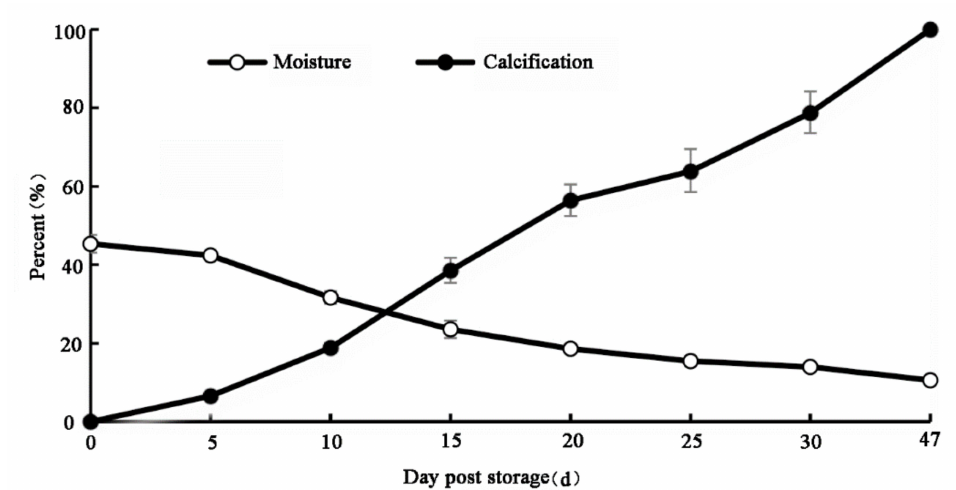
Figure 1. Relationship between the degree of chestnut calcification and the moisture content. Each experiment included three replicates. All of the data were expressed as means ± standard